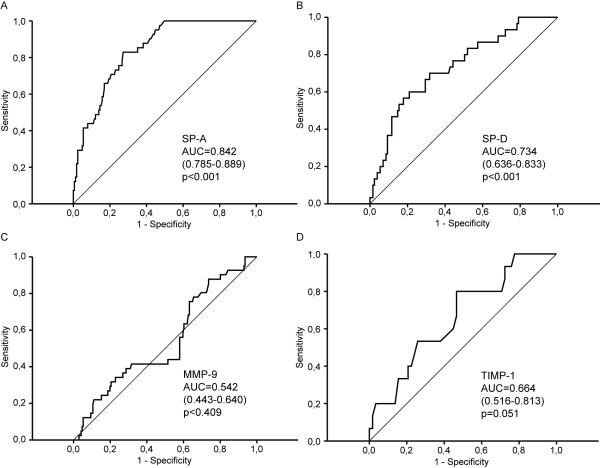
Receiver operating characteristic curves of SP-A, SP-D, MMP-9 and TIMP-1 in plasma (A, B, C and D, respectively) obtained from patients with COPD, young and middle aged/elderly smokers and the controls. Values in parentheses indicate 95% confidence intervals for the area under the curve (AUC).